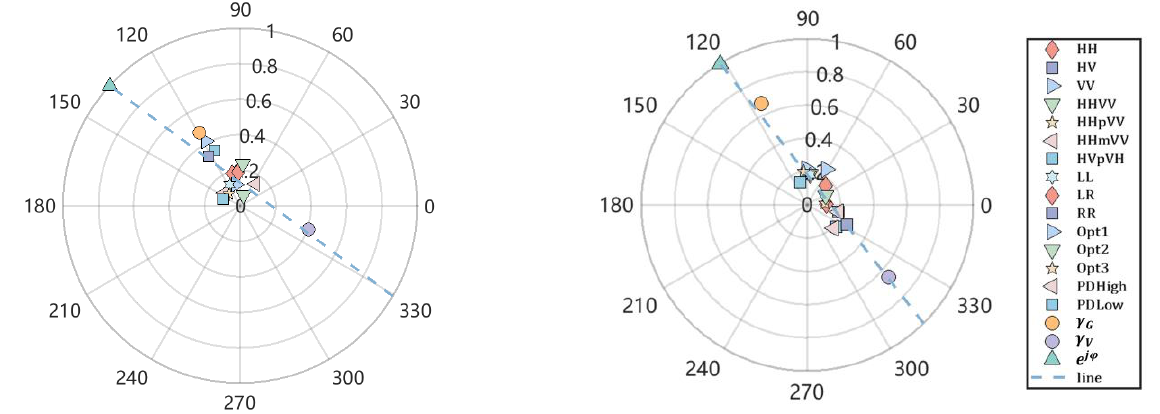
Figure 14. Fifteen common complex coherences (HH, HV, VV, HHVV, HH + VV, HH − VV, HV + VH, LL, LR, RR, Opt1, Opt2, Opt3, PD High, PD Low) and the complex coherences ( γ G , γ V ) obtained in this study were used for the comparison of GVR at low and high forest stand densities. Left: low density; right: high density.